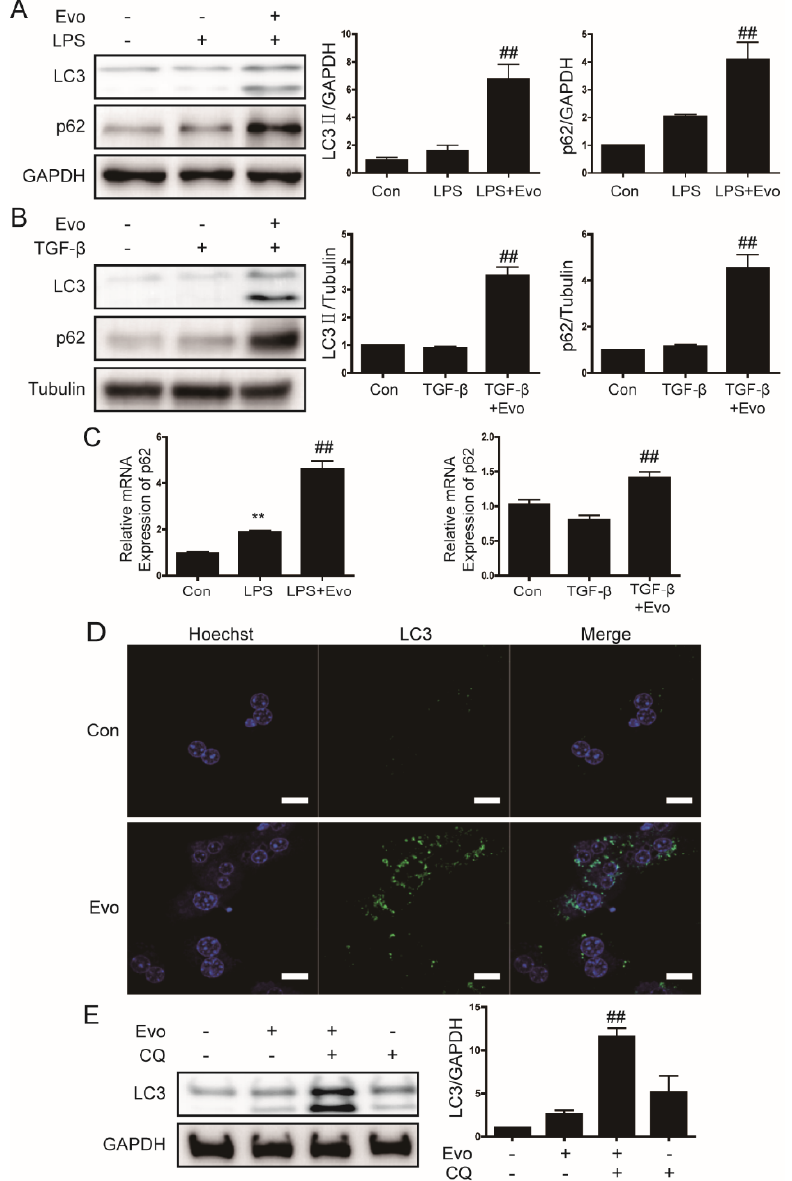
Figure 4. The effect of evogliptin on autophagy. ( A , B ) Representative Western blots showing the effects of evogliptin on LC3 and p62 levels in primary hepatocytes. Data in the bar graphs are represented as the mean ± SEM. ## p < 0.01 relative to LPS or TGF- β . ( C ) Representative real-time RT-PCR analysis of the effect of evogliptin on p62 mRNA levels. Data in the bar graph are the mean ± SEM. ** p < 0.01 relative to the control, ## p < 0.01 relative to LPS/TGF- β . ( D ) Primary hepatocytes were treated with evogliptin, and LC3 puncta formation was analyzed by immunofluorescence; original magnification ×800. ( E ) A representative Western blot showing the effect of evogliptin and chloroquine (CQ, 10 μ M) on LC3 protein levels in primary hepatocytes. Data in the bar graph are represented as the mean ± SEM. ## p < 0.01 relative to the evogliptin or chloroquine.